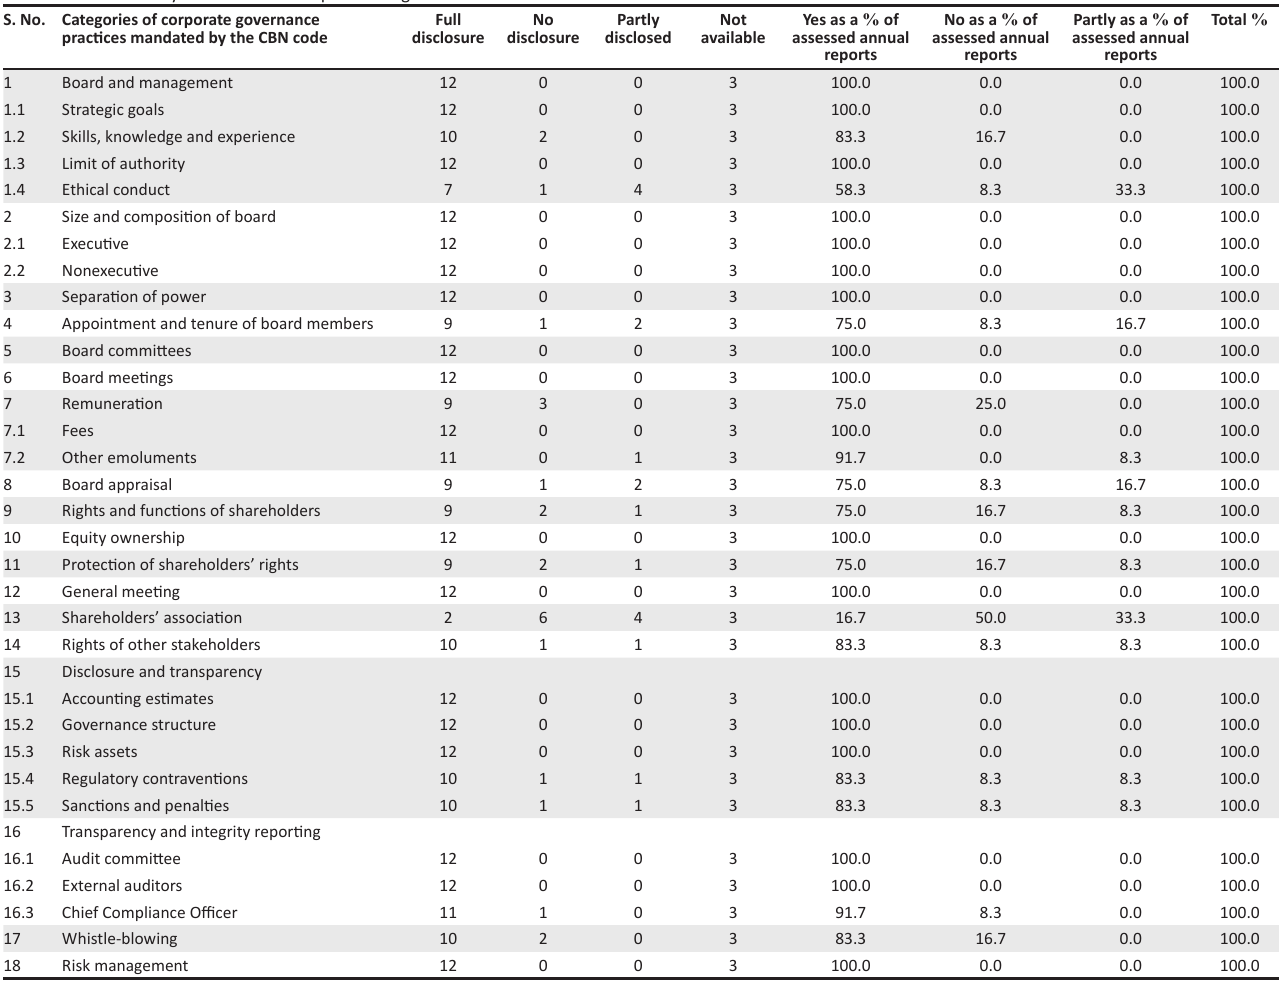
TABLE 4: Content analysis: 2015 annual reports of Nigerian banks. S. No. Categories of corporate governance practices mandated by the CBN